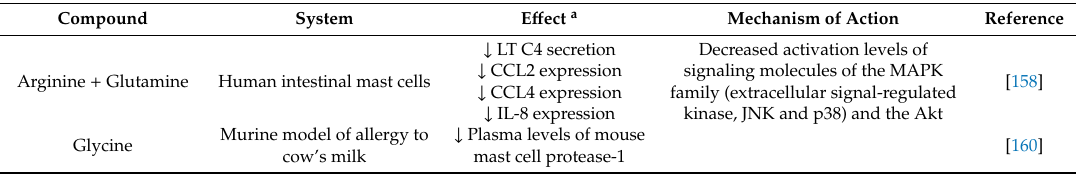
Table 5. Immunomodulatory e ff ects of amino acids on mast cell activity.